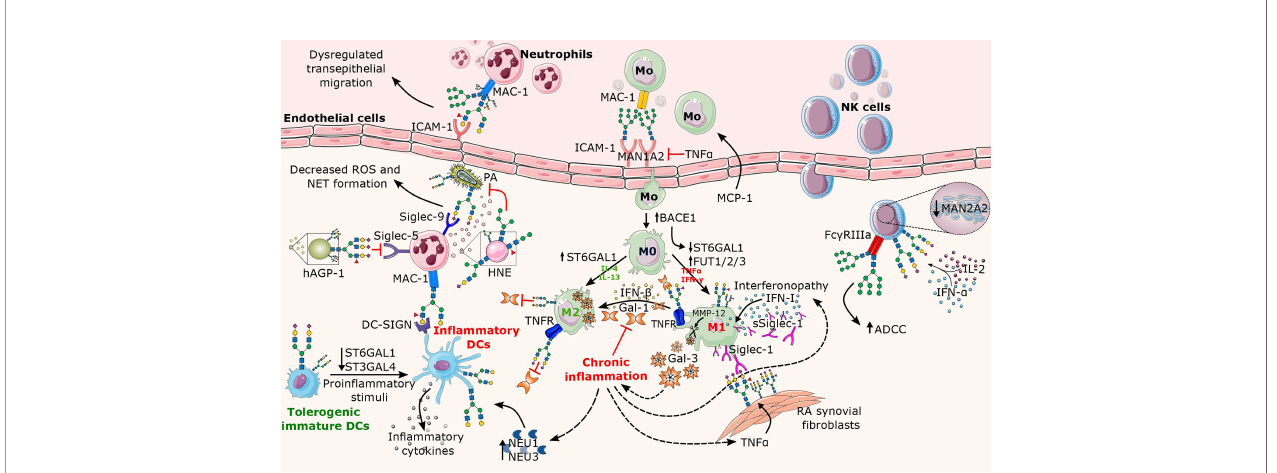
FIGURE 3 | Overview of altered N-glycosylation pathways in innate immune cells during chronic in fl ammation. The major factors contributing to the alterations in N- glycosylation are proin fl ammatory cytokines (e.g., TNF a , IL-2, IFN- a , IFN- g ) that are released in excess during in fl ammation. Here, the affected structural elements of N-glycans on the surface of innate leukocytes (neutrophils, macrophages, NK cells, and DCs) are shown along with their associated glycosyltransferases and glycosidases. In neutrophils, the increase of the Lex motif on the integrin MAC-1 leads to dysregulated neutrophil migration, whereas the binding of Lex decorated MAC-1 to DC-SIGN further triggers the activation of DCs. While neutrophilic granules (e.g., HNE) secreted by neutrophils carry truncated N-glycans, the presence of sialylated complex N-glycans and/or the sLex motif on Siglec counterbinding entities contributes to the in fl ammatory potential of neutrophils in a context-dependent manner. Proin fl ammatory cytokines enhance transport of monocytes and direct their differentiation into proin fl ammatory M1 macrophages, while contributing to the absence of sialylated N-glycans, cleavage of Gal-3, and increase in Siglec-1 expression. While surface-bound Siglec-1 is involved in the autoimmune response in rheumatoid arthritis (RA), soluble Siglec-1 is a marker in interferonopathy. In addition, the Gal-1/IFN- b feedback loop involved in termination of in fl ammation appears to be dysregulated in chronic in fl ammation. Similarly to macrophages, mature DCs also lack terminal sialic acids, plausibly due to in fl ammation-mediated decrease in sialyltransferase and/or increase in neuraminidase activity. As for NK cells, the presence of oligomannose N-glycans on Fc g RIIIa signi fi cantly increases ADCC, whereas cytokine-induced increase in sialylation abrogates Siglec-9-dependent NK cell inhibition by cis-binding. BACE1, Beta-Site APP-Cleaving Enzyme 1; Gal, galectin; hAGP-1; hepatic a 1-acid glycoprotein; HNE, human neutrophilic elastase; IFN, interferon; IL, interleukin; ICAM-1, intercellular adhesion molecule 1; MAC-1, macrophage-1 antigen; Man, Mannosidase; MMP-12, matrix metalloproteinase 12; MCP-1, monocyte chemoattractant protein-1; NEU, neuraminidase; NAGP-1, neutrophil a 1-acid glycoprotein; PA, Pseudomonas aeruginosa